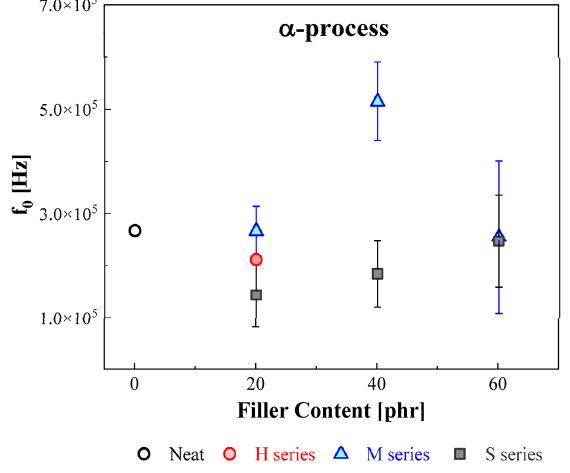
Figure 3. Variation of the central frequency for the α process in NBRs with different filler types and contents. The red circle indicates the H series, and the blue triangle and gray square symbols indicate the M and S series, respectively.